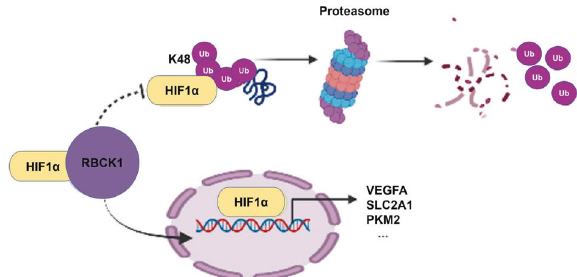
Fig. 7 The hypothetical model of the mechanism by which RBCK1 regulates HIF1 α signaling in ER + breast carcinoma. RBCK1 promoted target gene activation of HIF1 α pathway and accelerated the progression of ER-positive breast cancer by interacting with HIF1 α protein and inhibiting HIF1 α ubiquitination at K48 ubiquitination